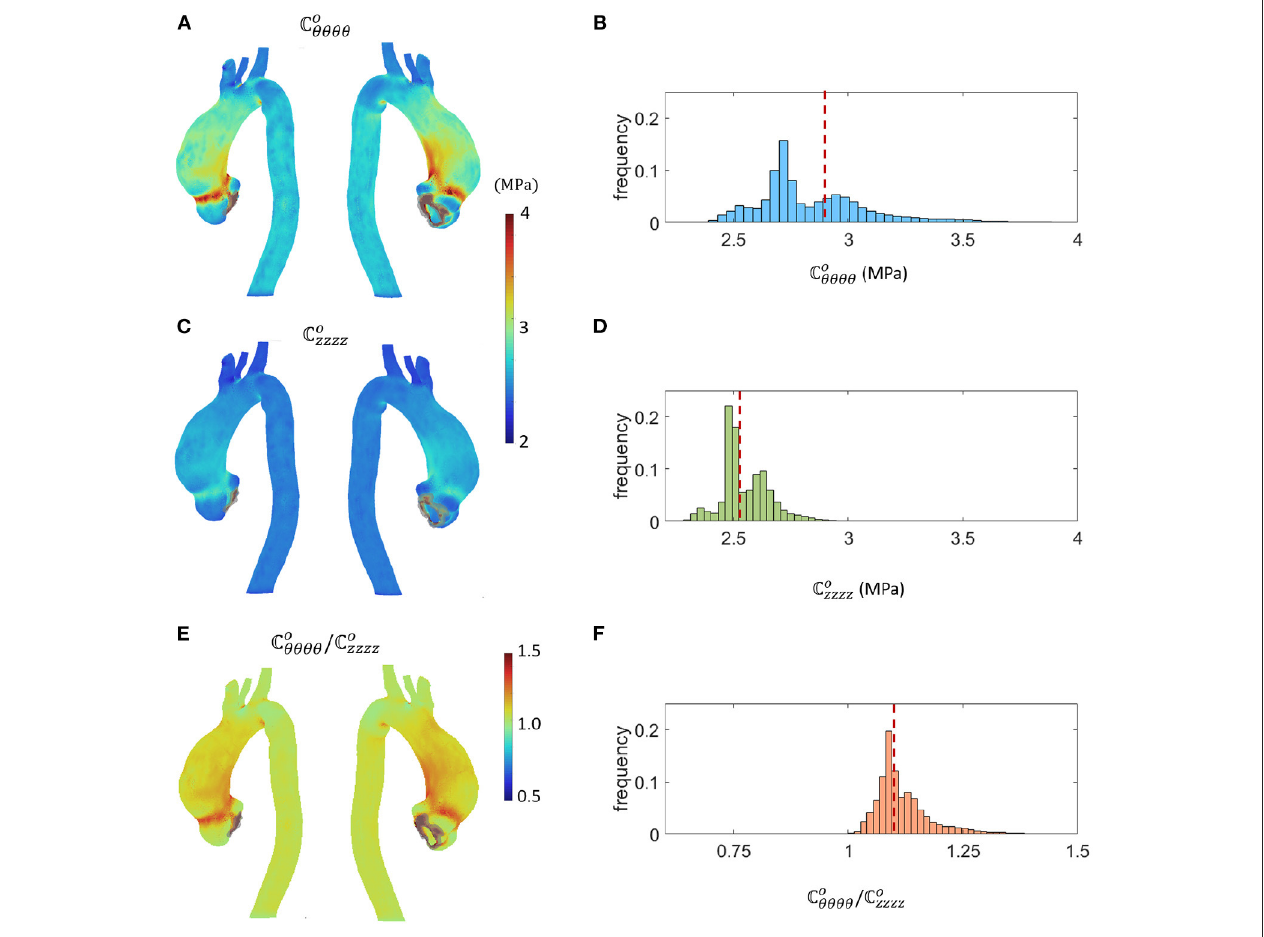
FIGURE 5 | Results from the LD simulation in terms of (A,B) C o θθθθ , (C,D) C o zzzz and (E,F) C o θθθθ / C o zzzz ratio. Outlier terms were grayed in the maps. Dashed lines in the bar plot distributions highlight the mean